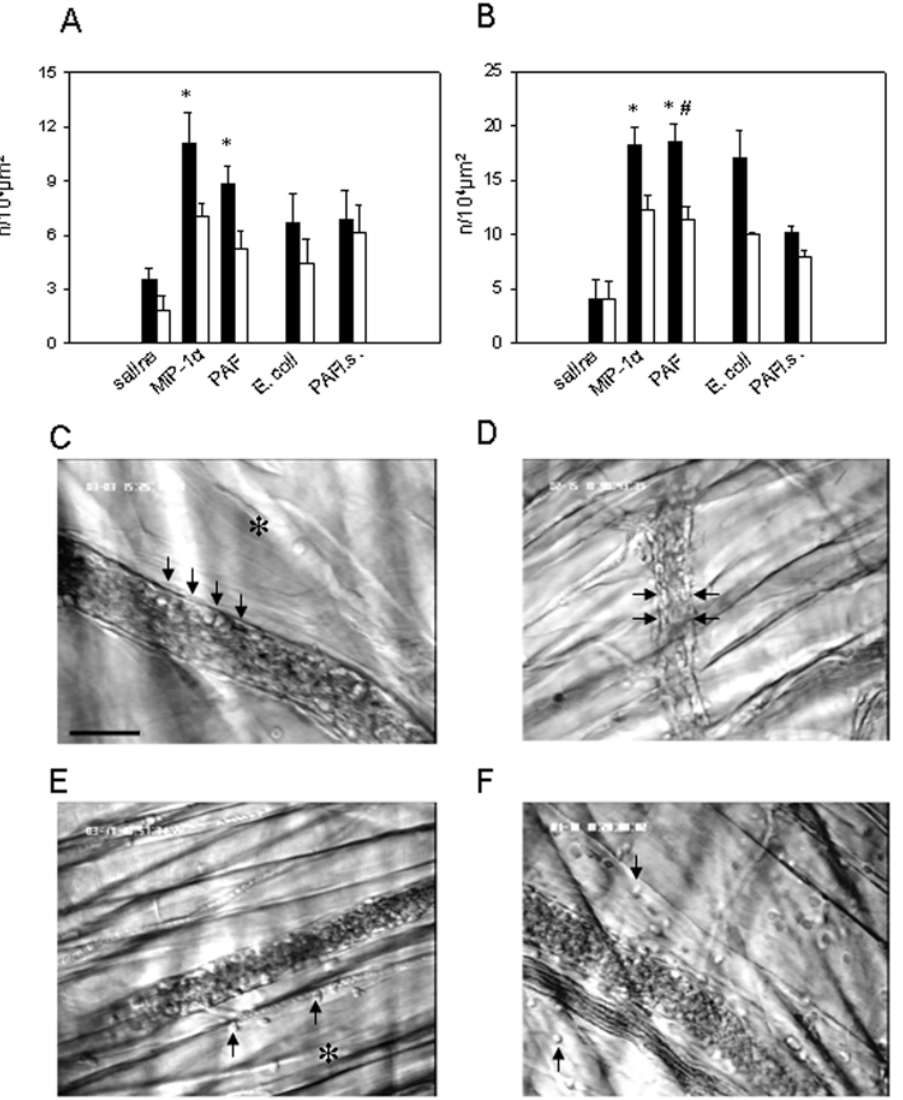
Figure 3. Leukocyte adhesion and transmigration. Numbers of adherent (A) and transmigrated (B) leukocytes at 60 minutes after microinjection of saline, MIP-1 a , PAF, or E. coli , and after intrascrotal injection of PAF (PAF i.s.) were counted on the vessel side ipsilateral to the microinjection site (black bars) and on the contralateral side (white bars); mean 6 SEM; n=6; * , 0.05 vs. ipsilateral side, # , 0.05 vs. PAF- contralateral side; E. coli n=3; PAF i.s. n=3. C–F: intravital microscopic images from the murine cremaster muscle demonstrate adherent and emigrated leukocytes (arrows) after microinjection (C and E, respectively) and intrascrotal injection of PAF (D and F, respectively); asterisk shows the site of microinjection; objective magnification 20 6 ; scale bar 25 m